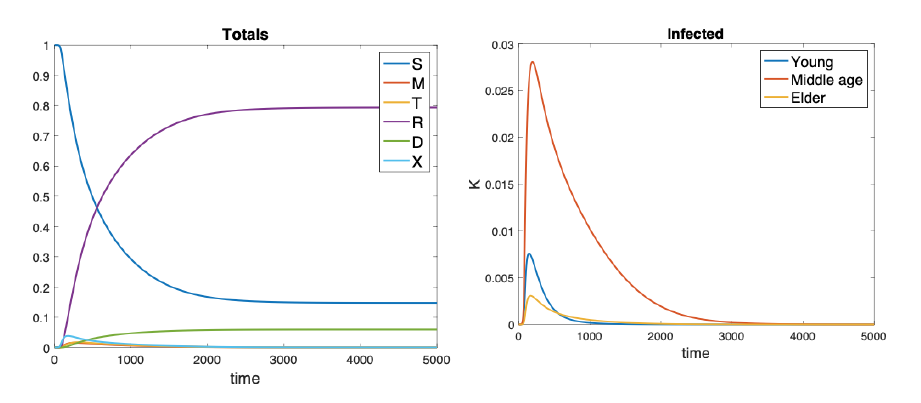
Figure 11. 𝑐 , other parameters as in Table 1. (top left) total fractions; (top right) infected for different age classes; 0 = 100 (bottom left) people in therapy; (bottom right) deaths on a log-log scale.